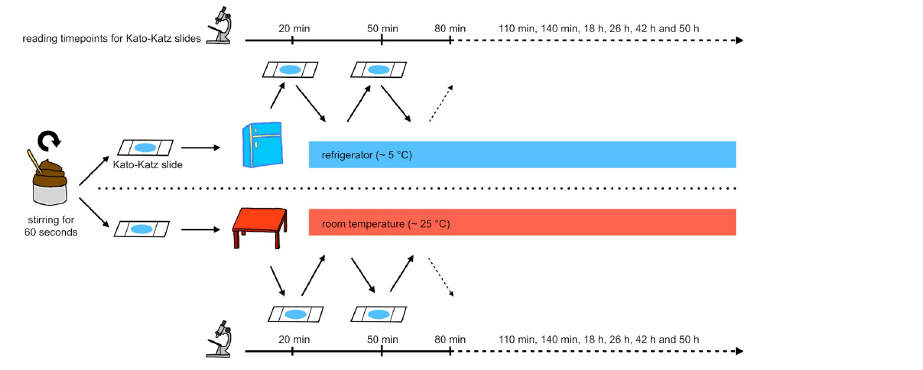
Fig 1. Procedure of the Kato-Katz storing experiment.